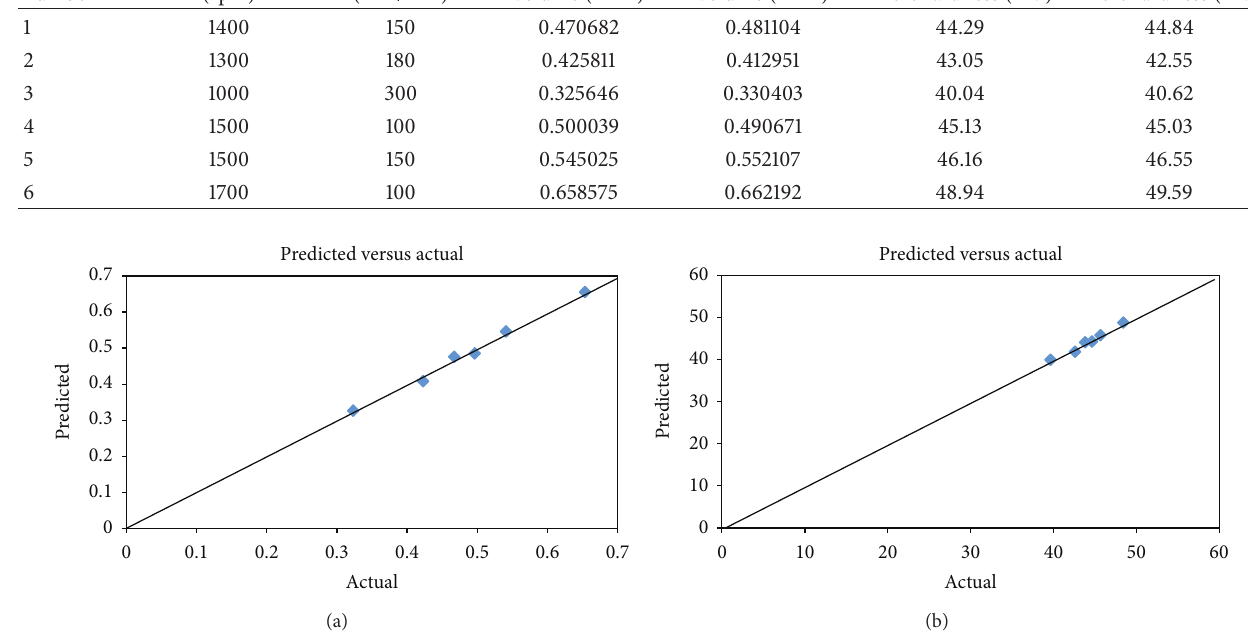
Figure 15: The graph of predicted versus actual experimental data of (a) wear volume and (b) Vickers